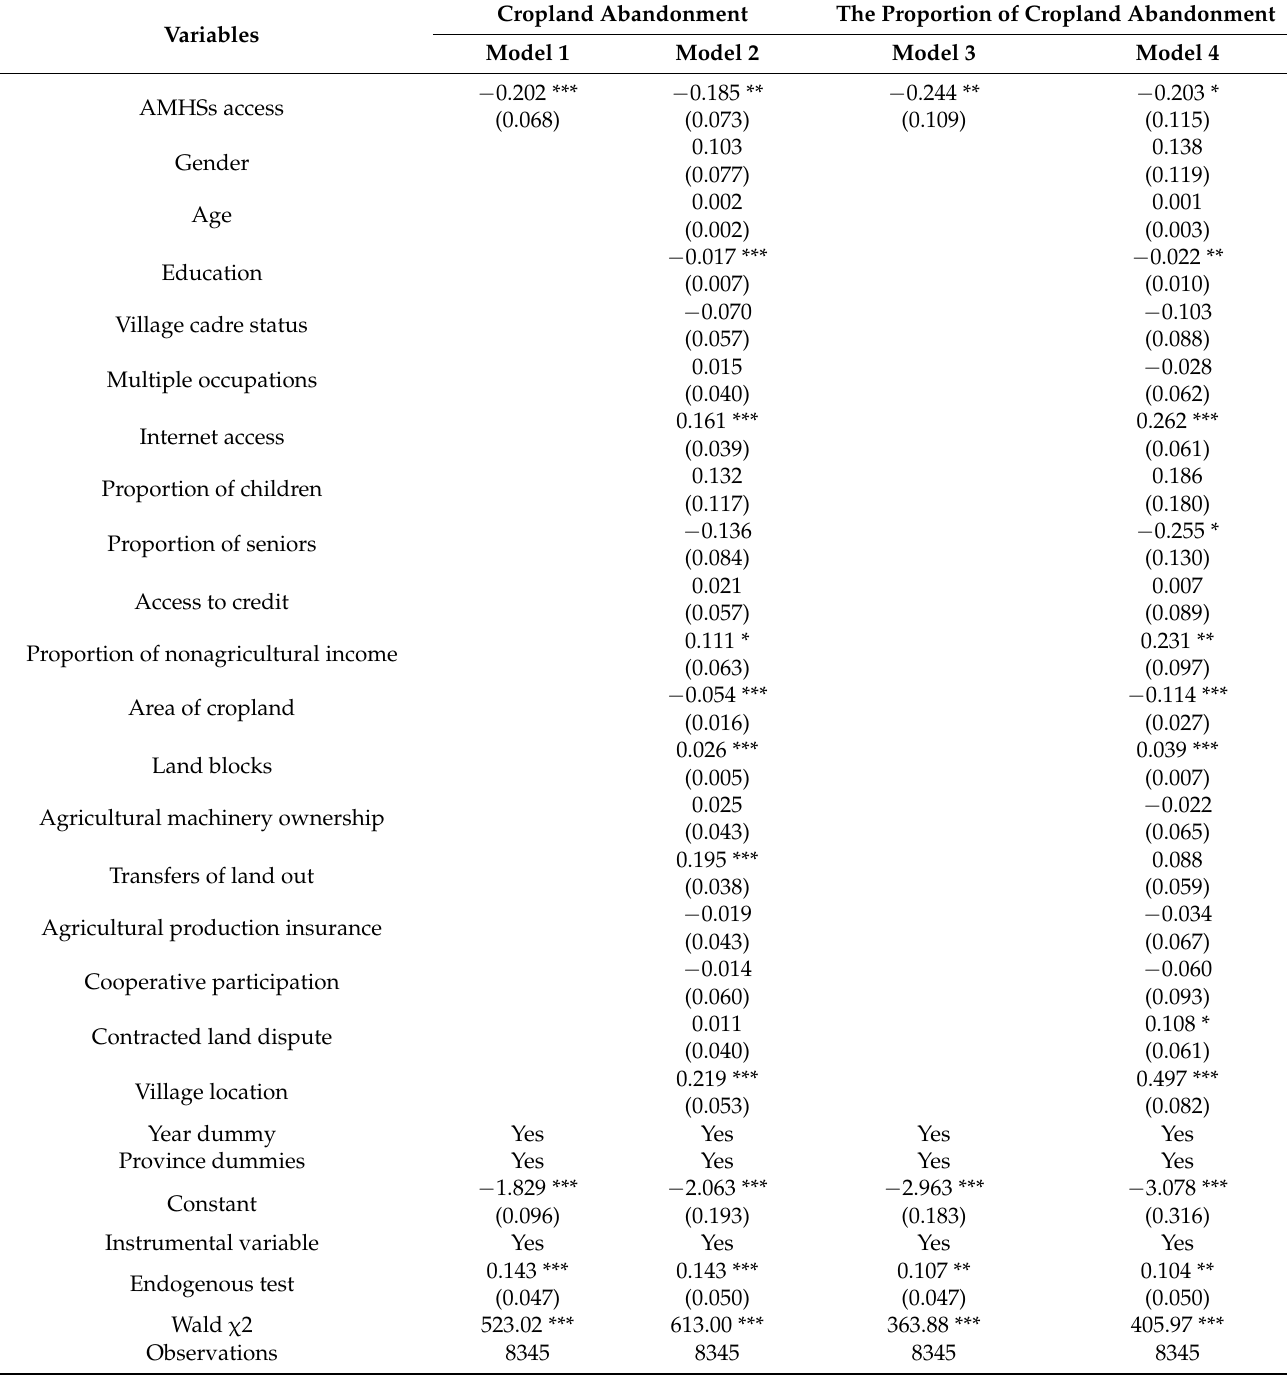
Table 2. The estimation results of cropland